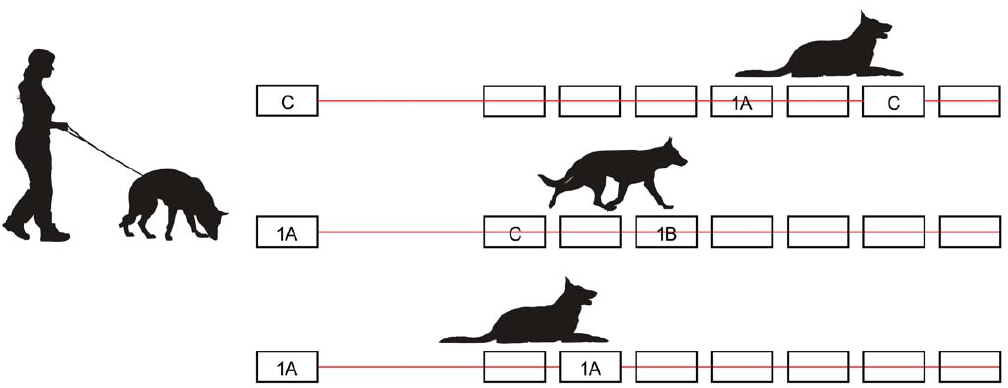
Figure 2. Scheme showing examples of how the scent identification line-ups were performed. 1A is a scent of the first twin and 1B is a scent of the second twin of the same pair. The blank rectangles stand for the distracting scents. An interrupted line signifies that the dog alerted to the scent. C is a control scent or training scent used by the handler for training purposes to let the dog make positive matches. The dogs moved from left to right. The separated rectangles on the left represent starting scent. In the first line-up, a twin’s scent served as an attractor in a control line-up. Any given dog smelled the starting scent and was sent to search for the matching scent, while ignoring the attractor (top). A correct result of the middle line-up would be ‘‘not matched’’ i.e. the dog did not match the two scents. The bottom row shows matching of two scents collected from a single twin. In this case the correct result would be ‘‘matched’’ as required.